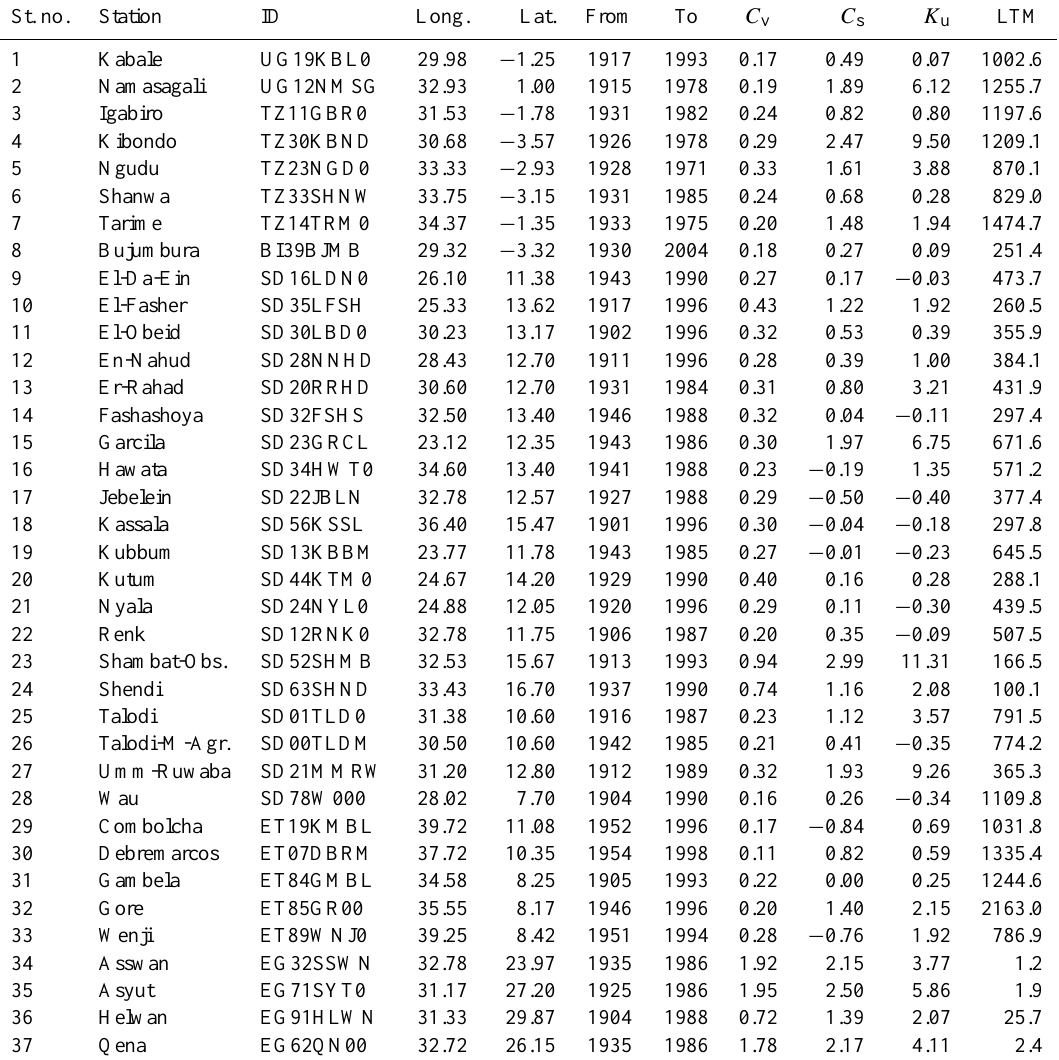
Table 1. Overview of selected stations and their annual rainfall data. St.